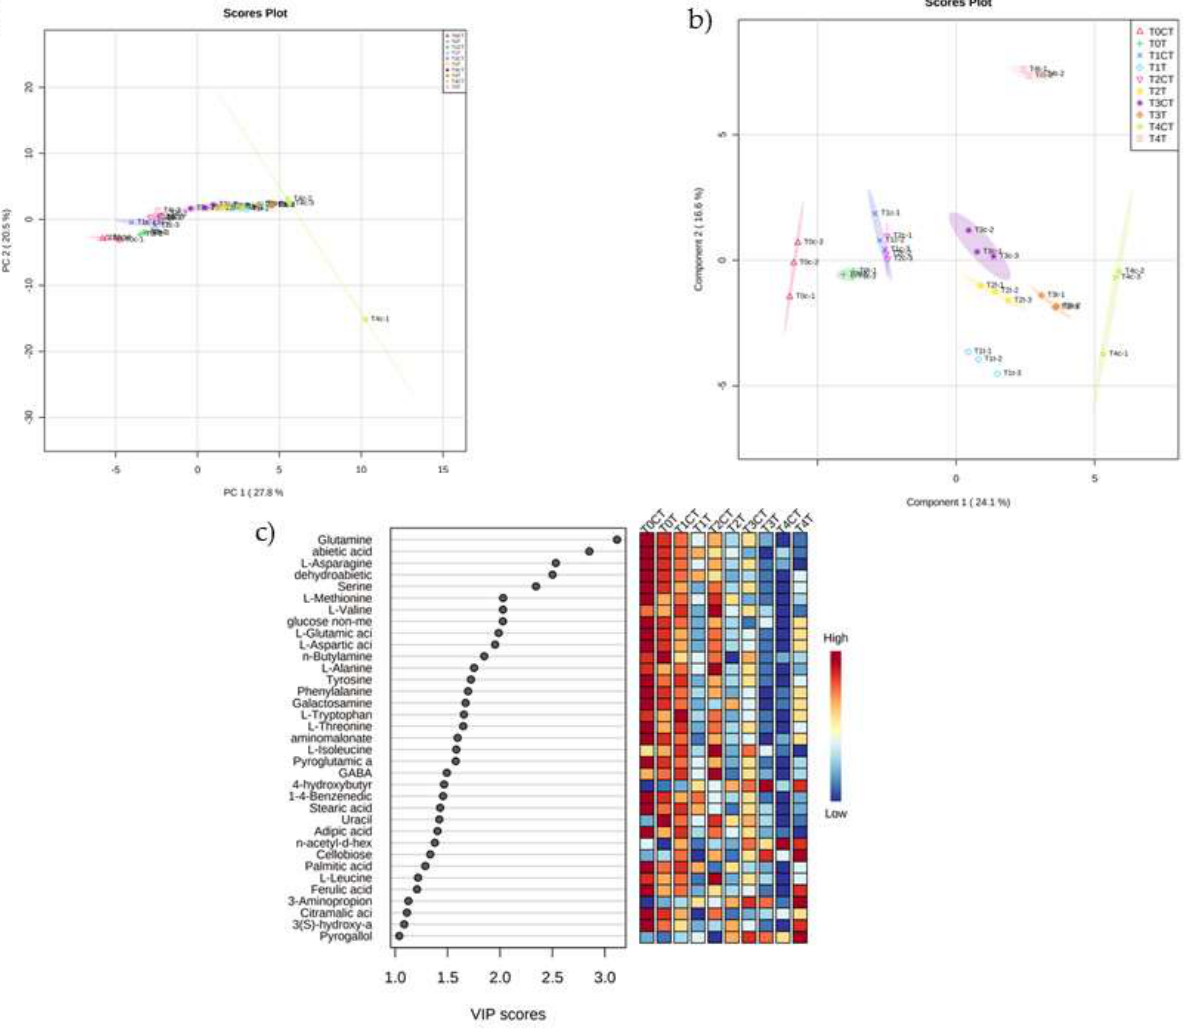
Figure 2. ( a ) Unsupervised PCA of the metabolomic changes on maize roots after 48 h treatment with 103 µ M of trans − cinnamic acid. ( b ) Multivariate (PLS − DA) analysis of the metabolomic changes on maize roots after 48 h treatment with 103 µ M of trans − cinnamic acid. ( c ) Important features identified by PLS − DA. The coloured boxes on the right indicate the relative concentrations of the corresponding metabolite in each group under study Times (T0 = 0 h; T1 = 6 h; T2 = 12 h; T3 = 24 h; T4 = 48 h). The treatments used were 0 µ M (control, CT), and (treatment, T). N = 3. PLS-DA derived variable importance of projection (VIP) scores (built on the metabo- lites with a VIP score higher than 1.4) (Figure 2c) revealed that glutamine, abietic acid, L-asparagine, dehydroabietic acid, serine, L-methionine, L-valine, glucose, L-glutamic acid, L-aspartic acid, n-butylamine, L-alanine, tyrosine, phenylalanine, galactosamine, L-tryptophan, L-threonine, aminomalonate, L-isoleucine, pyroglutamic acid, gamma- aminobutyric acid (GABA), 4-hydroxybutyric acid, 1-4-benzenedicarboxylic acid, stearic acid, uracil, and adipic acid were the metabolites that were mainly contributing to groups discrimination (Figure